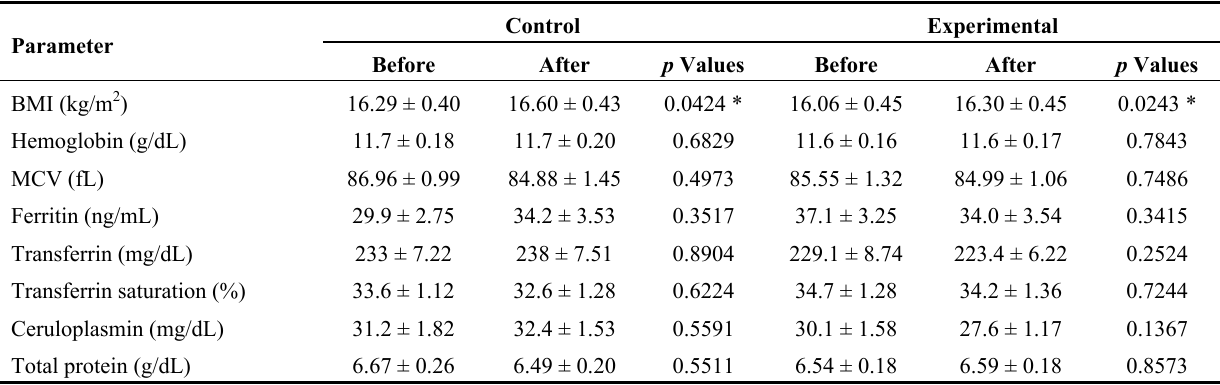
Table 1. Body Mass Index (BMI) values and results for hemoglobin, mean corpuscular volume, ferritin, transferrin, transferrin saturation, ceruloplasmin and total protein in the control and experimental